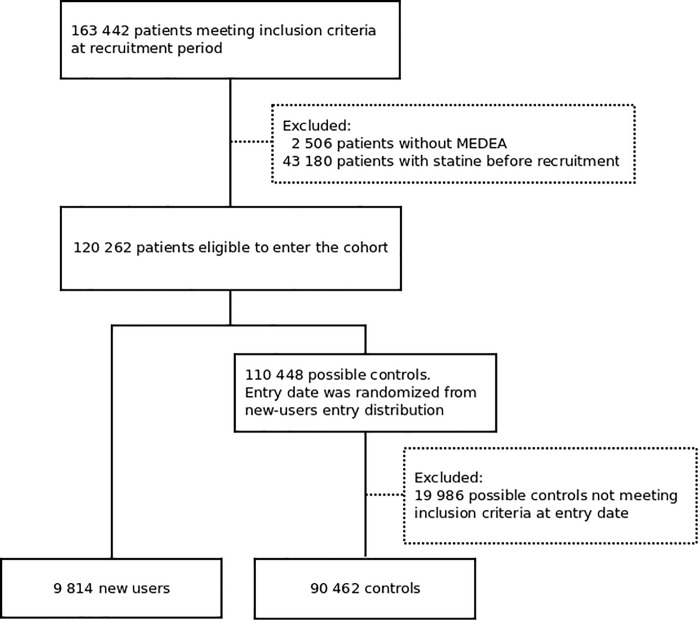
Study flowchart.